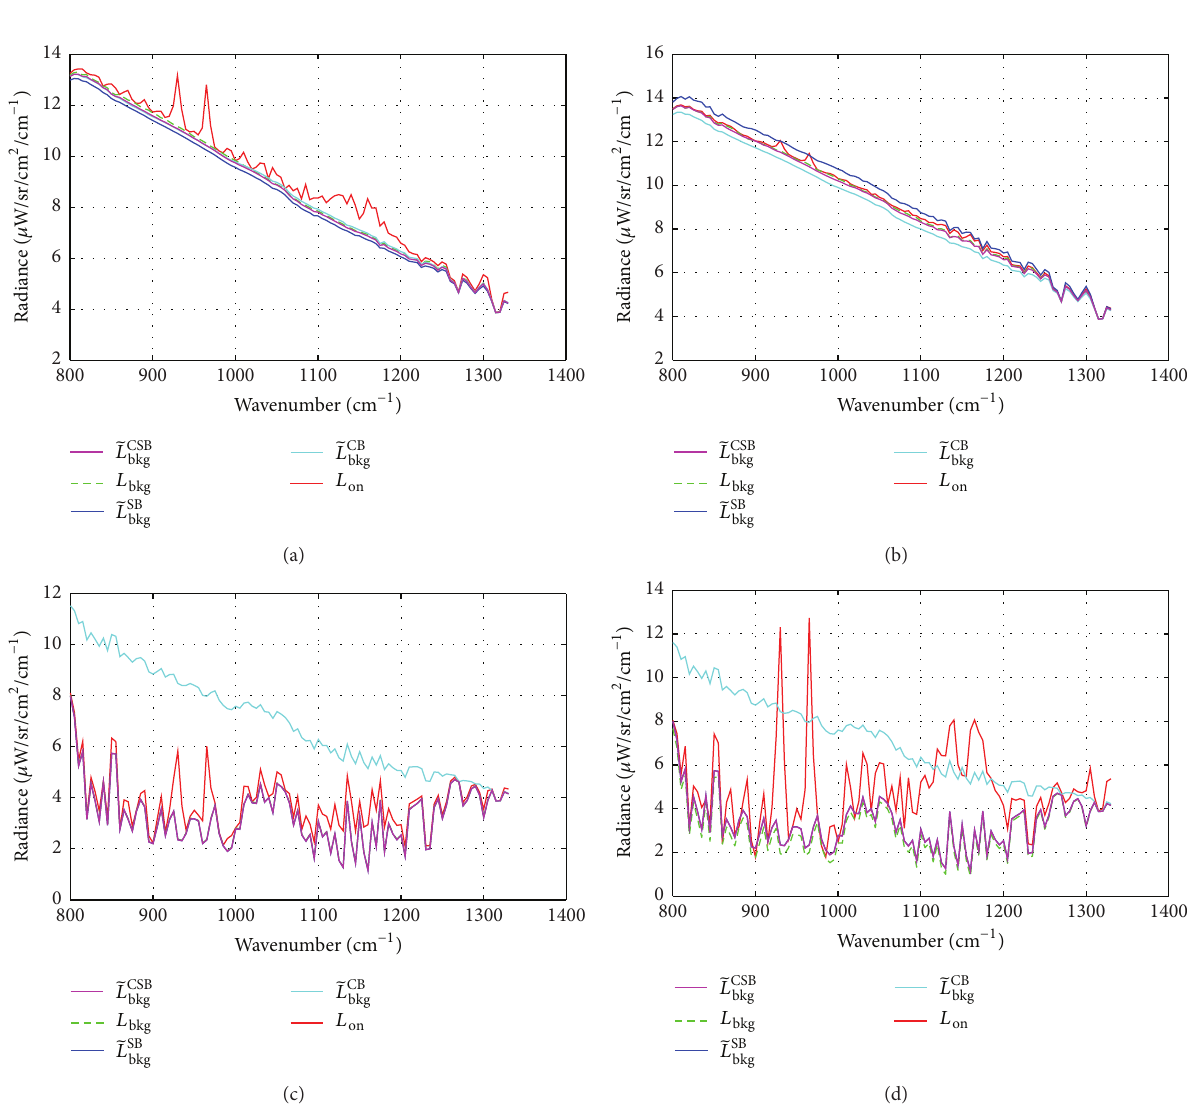
Figure 10: Comparison of background radiance estimation methods, for four different pixels through the plume. The red curves stand for the on-plume radiances; the dotted green ones are the real background radiances. The cyan, blue, and magenta curves represent, respectively, the background radiance estimated by the SB, CB, and CSB methods. (a) Results for pixel 1 (brown sandy loam), (b) results for pixel 2 (asphalt), (c) results for pixel 3 (aluminum), and (d) results for pixel 4